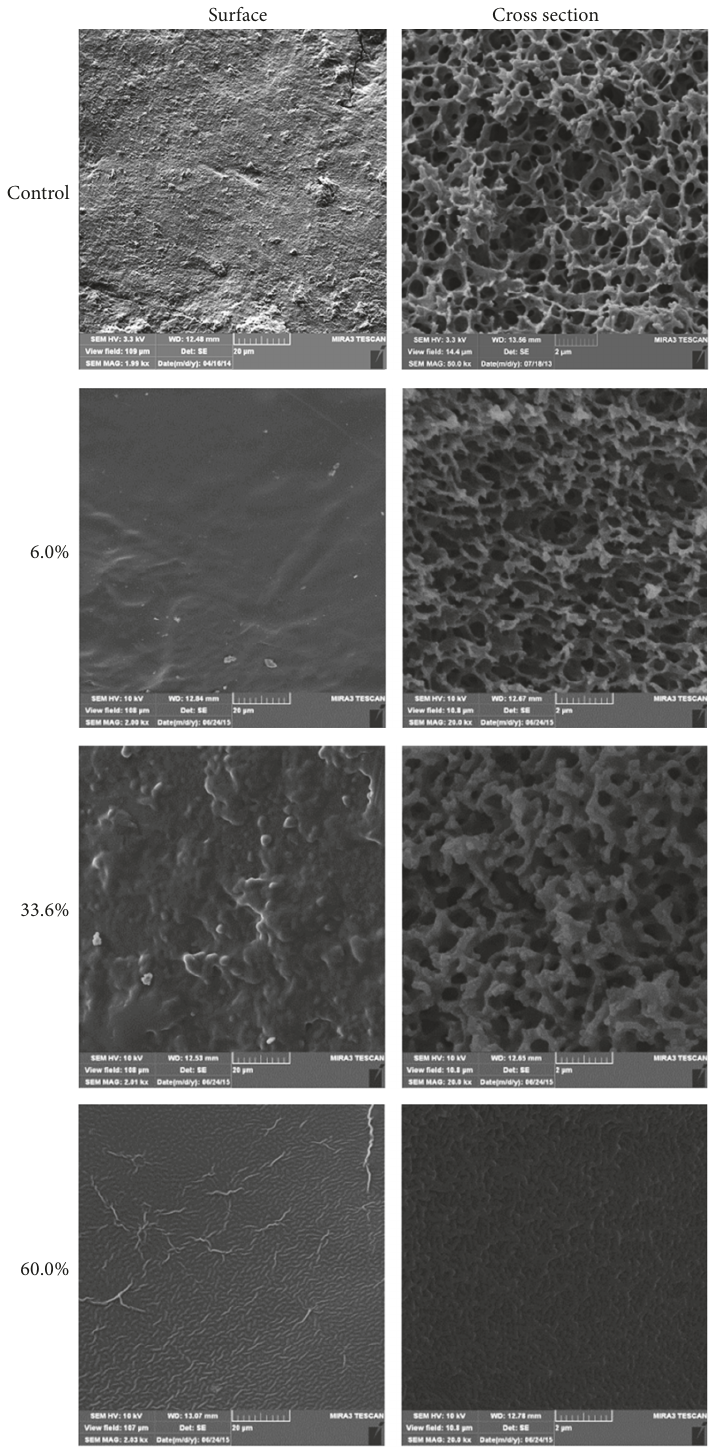
Figure 5: SEM images of cellulose acetate